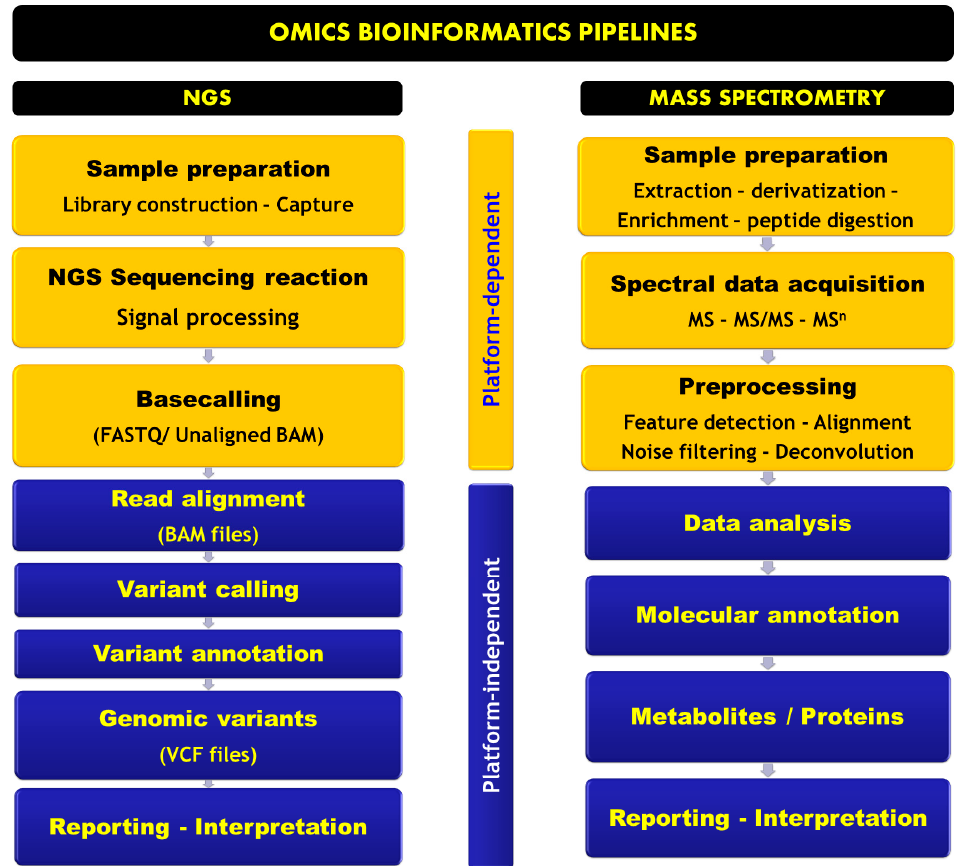
Figure 2. Schematic illustration of bioinformatics pipelines in next-generation sequencing (NGS) and mass spectrometry (MS)-based omics. Left : The NGS pipeline comprises library construction and capture, sequencing reaction, and signal processing. Then, a base-calling step is performed to define the unaligned nucleotide sequence. The data are stored in FASTAQ file format containing quality scores. Subsequently, read alignment to a reference sequence is performed, followed by variant calling and annotation. The final output is a list of variants in VCF format for visualization and interpretation; Right : MS pipeline starts with sample preparation, depending on the MS instruments and the combined separation method. Data acquisition is performed according to the chosen mode (full scan or tandem MS). Subsequently, a pre-processing step is needed for feature extraction and data cleaning. The result is a list of features that will undergo data analysis, molecular annotation, and identification before biological interpretation. Signal processing is platform-dependent in NGS; however, open source solutions are available for pre-processing MS data.